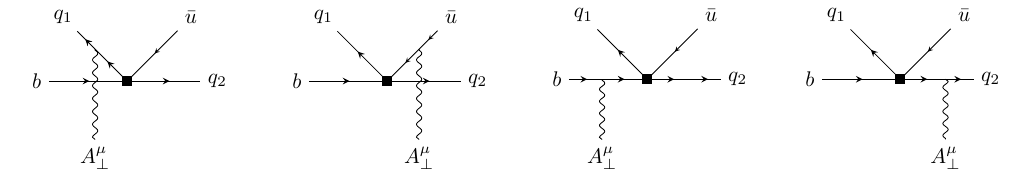
Figure 3 . O ( α em ) spectator-scattering corrections to H II